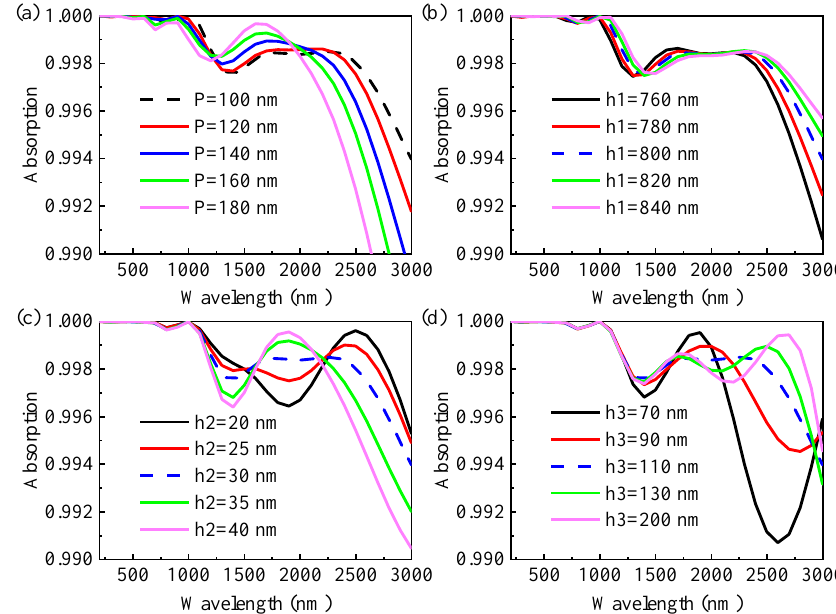
Figure 6. Effects of structural parameters on the absorbing properties: ( a ) period of unit cell P; ( b ) height of the pyramid h 1 ; ( c ) thickness of SiO 2 layer h 2 ; and ( d ) thickness of the underlying metal Ti layer h 3 .